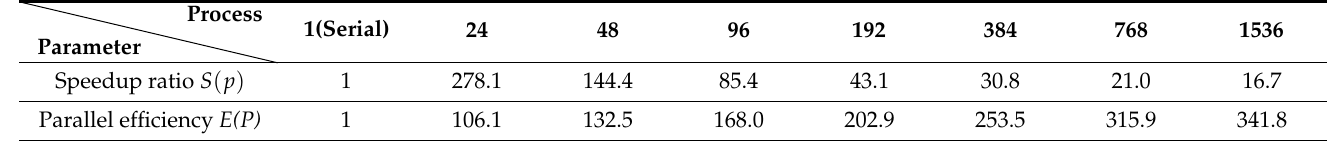
Table 7. The speedup ratio and parallel efficiency in the distributed communication